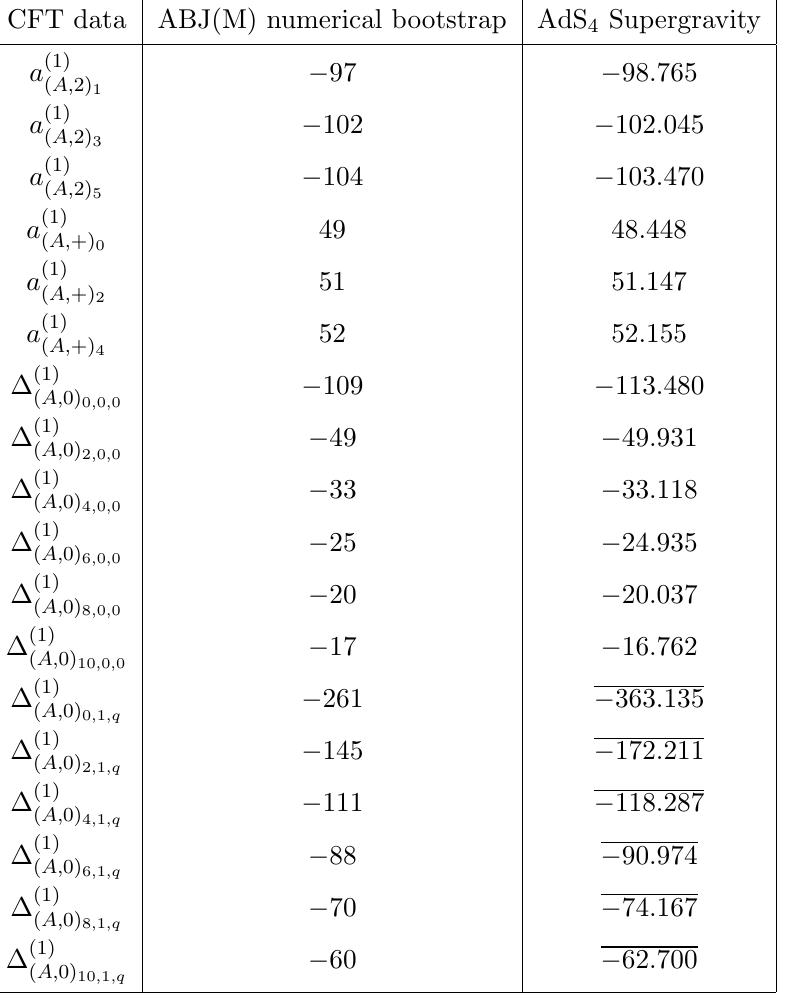
for the q = 0 ; : : : ; n unprotected ( A; 0) j;n;q and a (1) for ( A; +) j ( A; 2) j